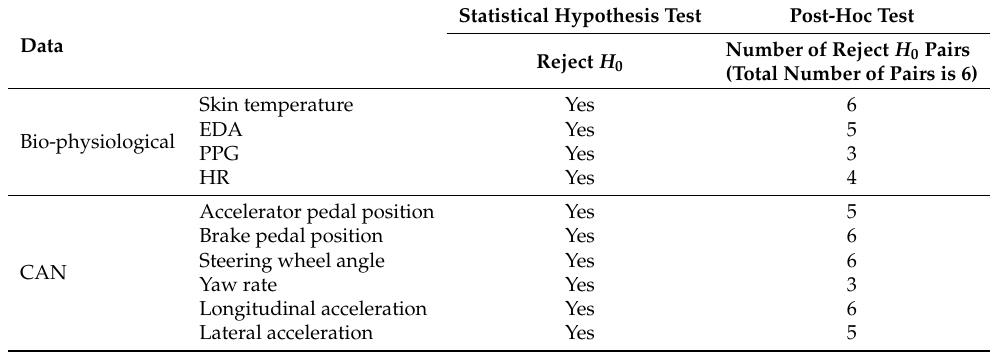
Table 3. Statistical hypothesis test results of structured data by self-reported emotion